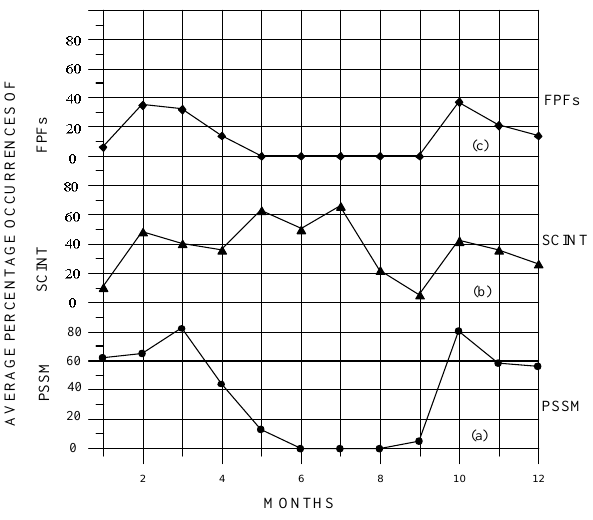
Fig. 2. Diagram showing monthly occurrence of PSSM, scintilla- tions and